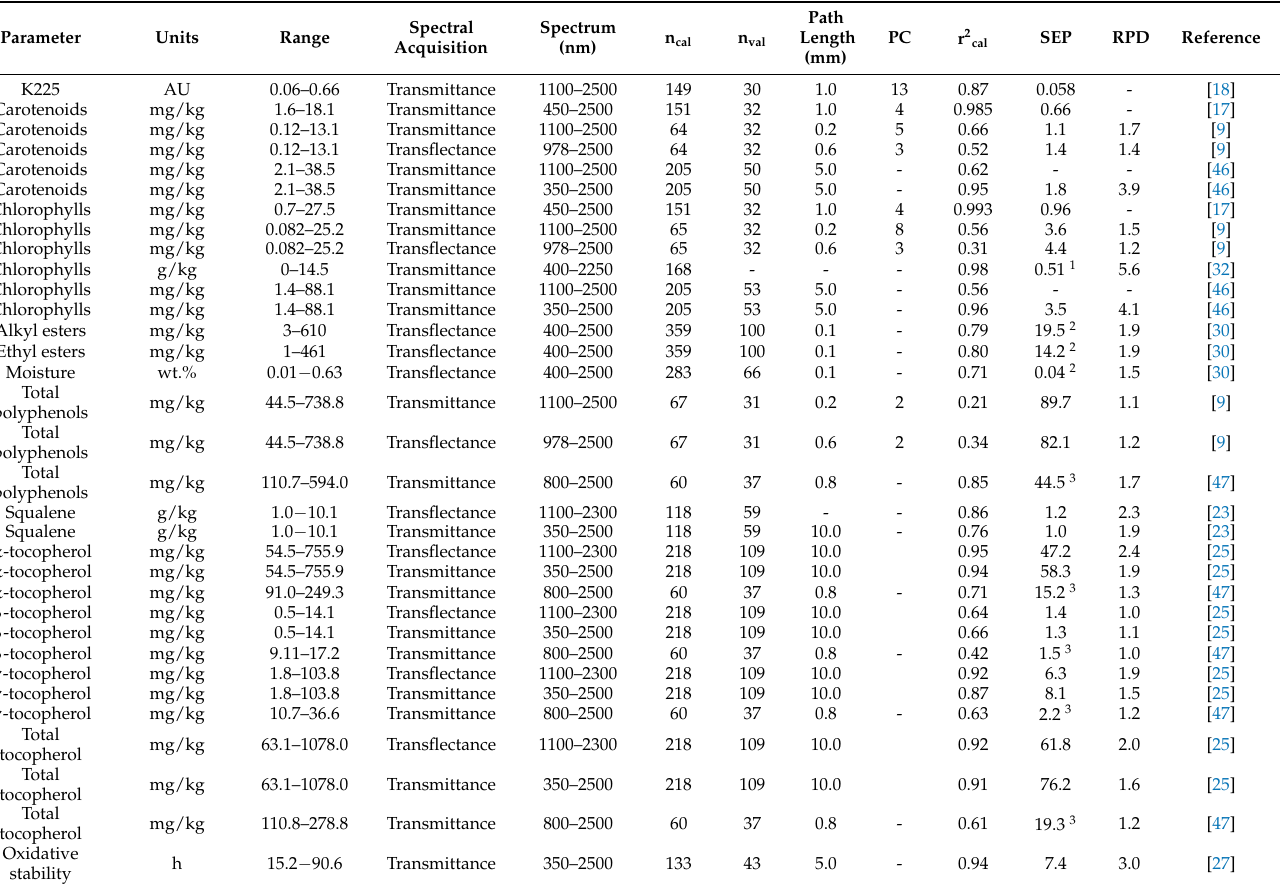
Table 7. PLS statistics obtained for different compounds and parameters of olive oils using different unit ranges, visible/NIR spectral intervals, and optical path